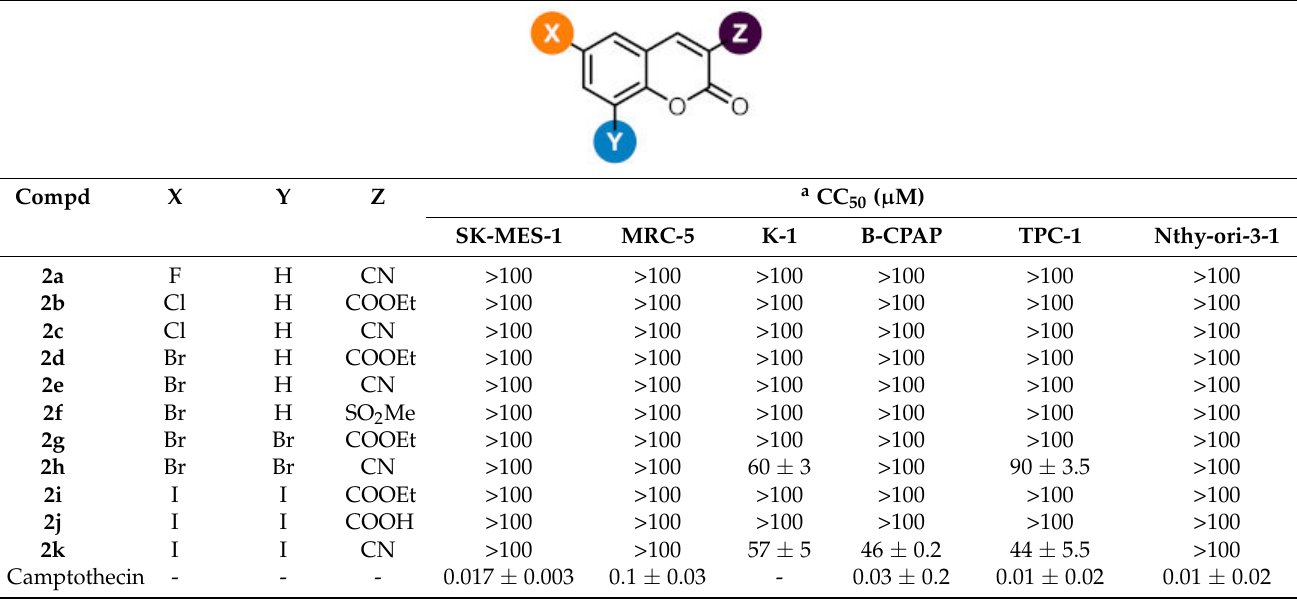
Table 1. In vitro inhibitory effects of coumarins 2a – k and reference compound camptothecin against different cancer and normal cell